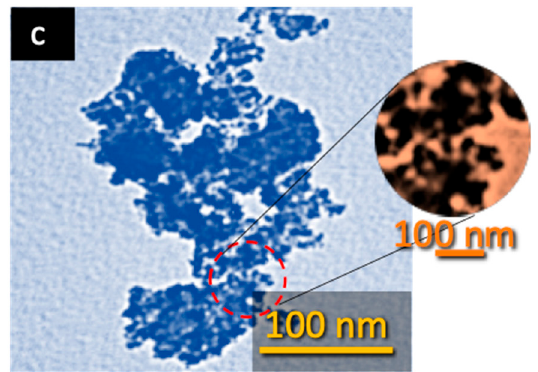
Figure 2. Scanning electron microscopy (SEM) images ( a , b ) and transmission electron microscopy (TEM) images ( c ) of MNP/CTAB–EC.